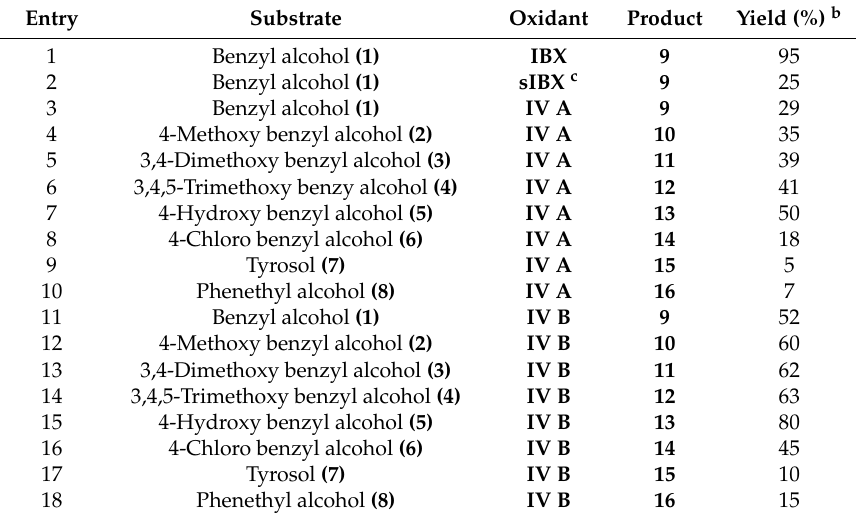
Table 4. Oxidation of compounds 1–8 with IV A–B a .